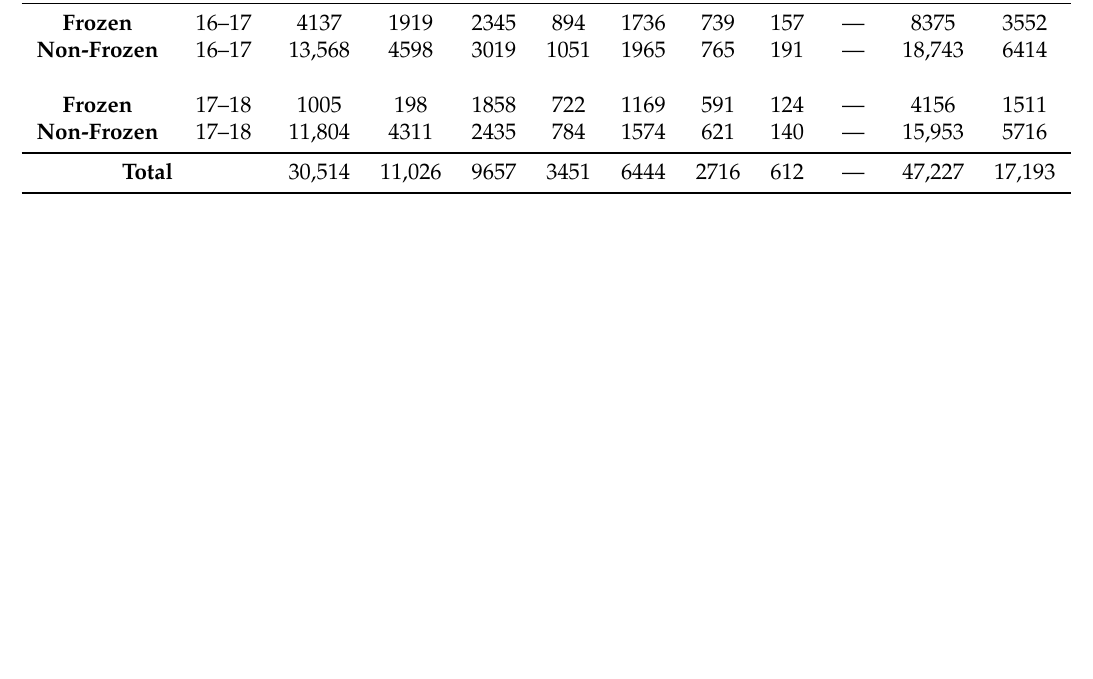
Table 4. Total number of clean, cloud-free pixels on non-transition dates from MODIS (M) and VIIRS (V) sensors (at least 30% cloud-free days) used in our experiments.